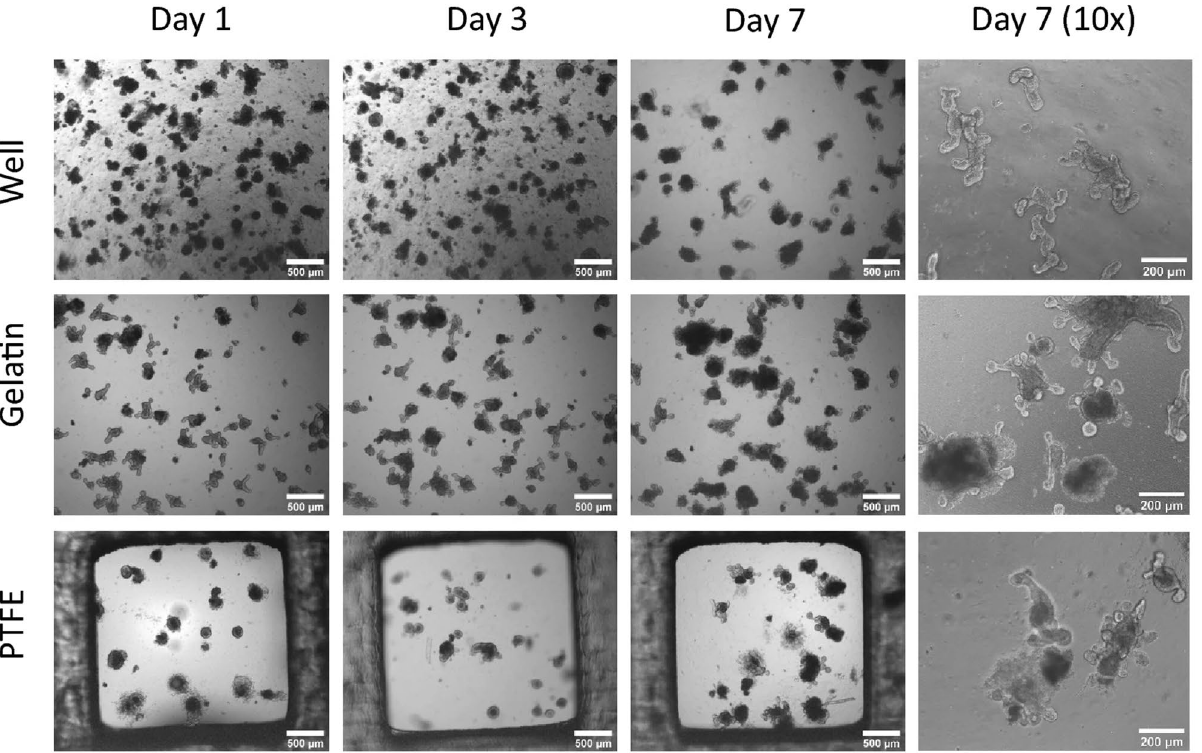
Figure 5. Representative light microscopy images of mouse intestinal organoids in Matrigel dome on hydrophilic PTFE filters and Gelatin membrane. Images (n = 3) were taken during their culture for 7 days in the insert plate wells with a light microscope (scalebar 500 µm for 4 × magnification; scalebar: 200 µm for the 10 ×